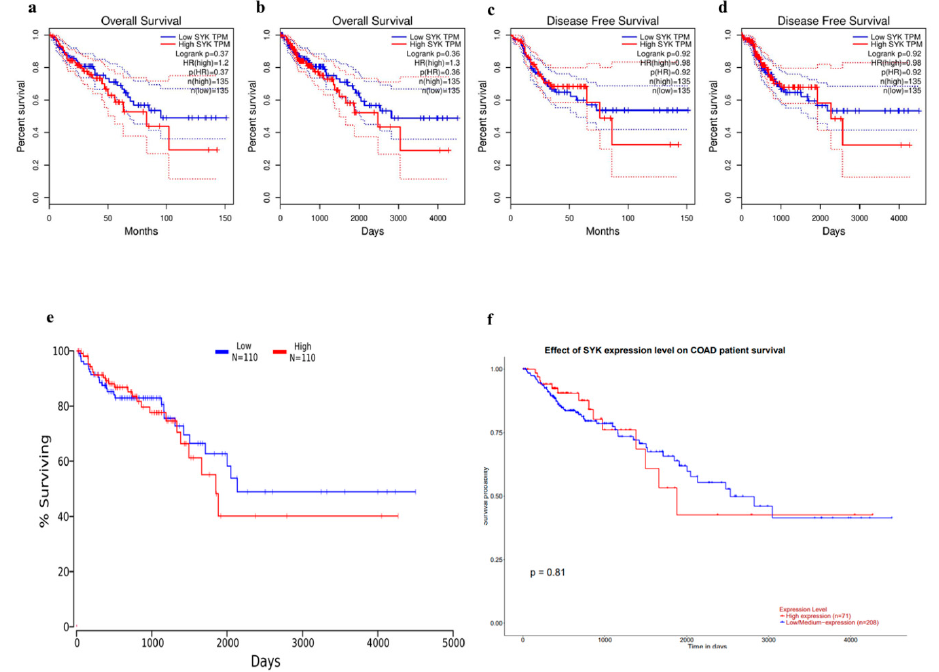
Figure 6. Survival assay for the SYK gene in CRC. ( a ) Survival plot from the GEPIA database. ( b ) Overall survival. ( c , d ) Disease-free survival. ( e ) Survival plot from the OncoLnc and ( f ) UALCAN database.